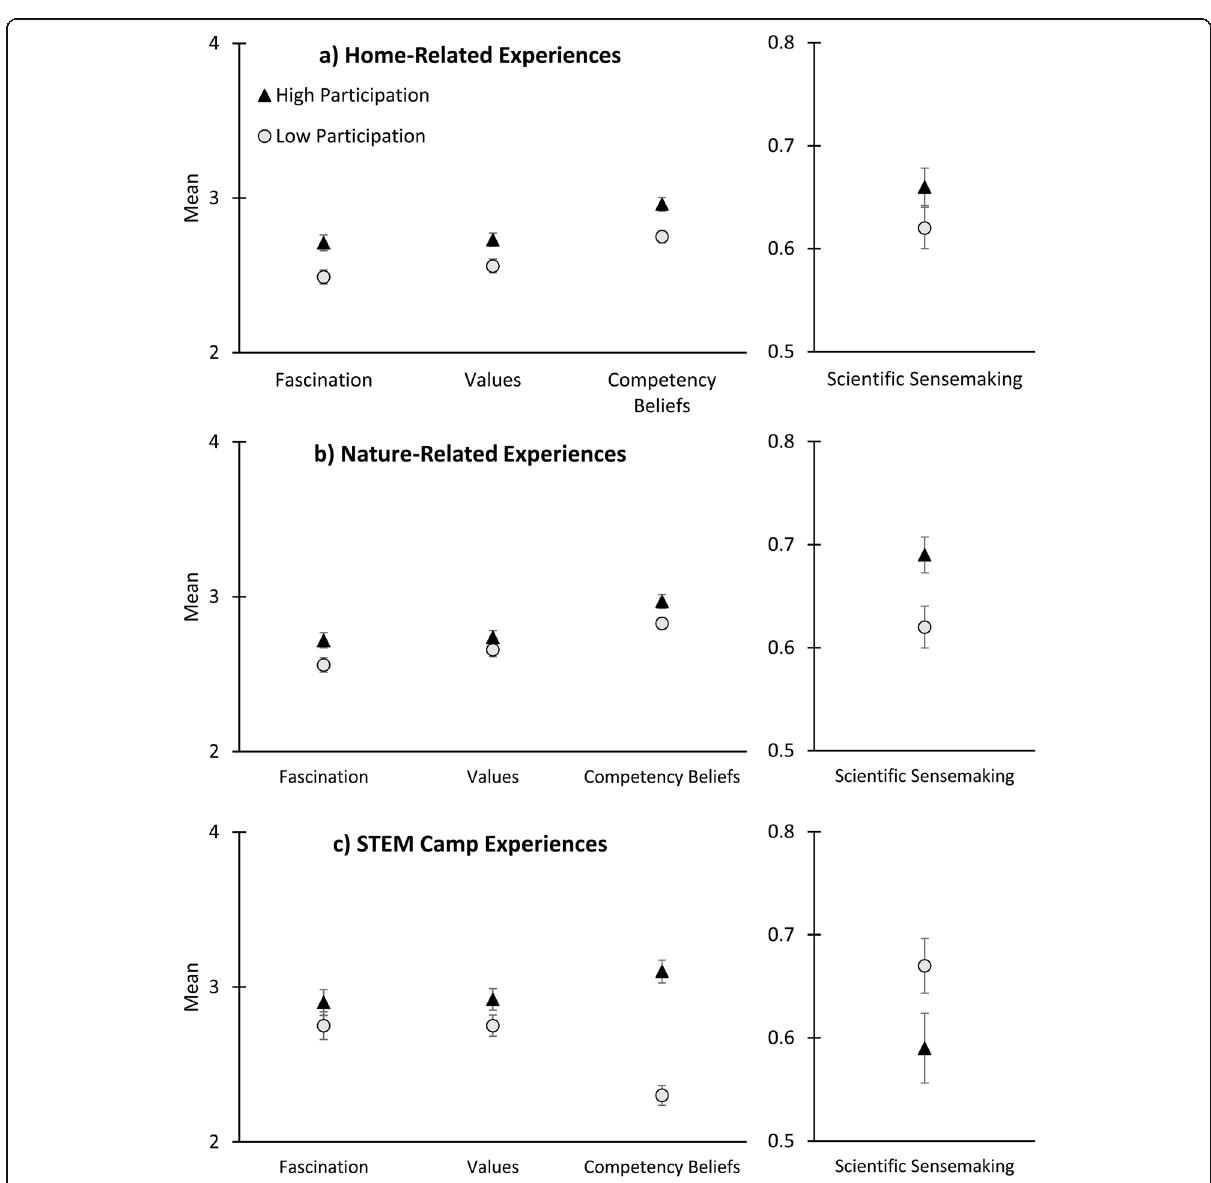
Fig. 5 For fascination, values, competency beliefs, and scientific sensemaking, post summer scores separately for high-participation vs. low- participation matched participants in a home-related experiences, b nature-related experiences, and c STEM camp